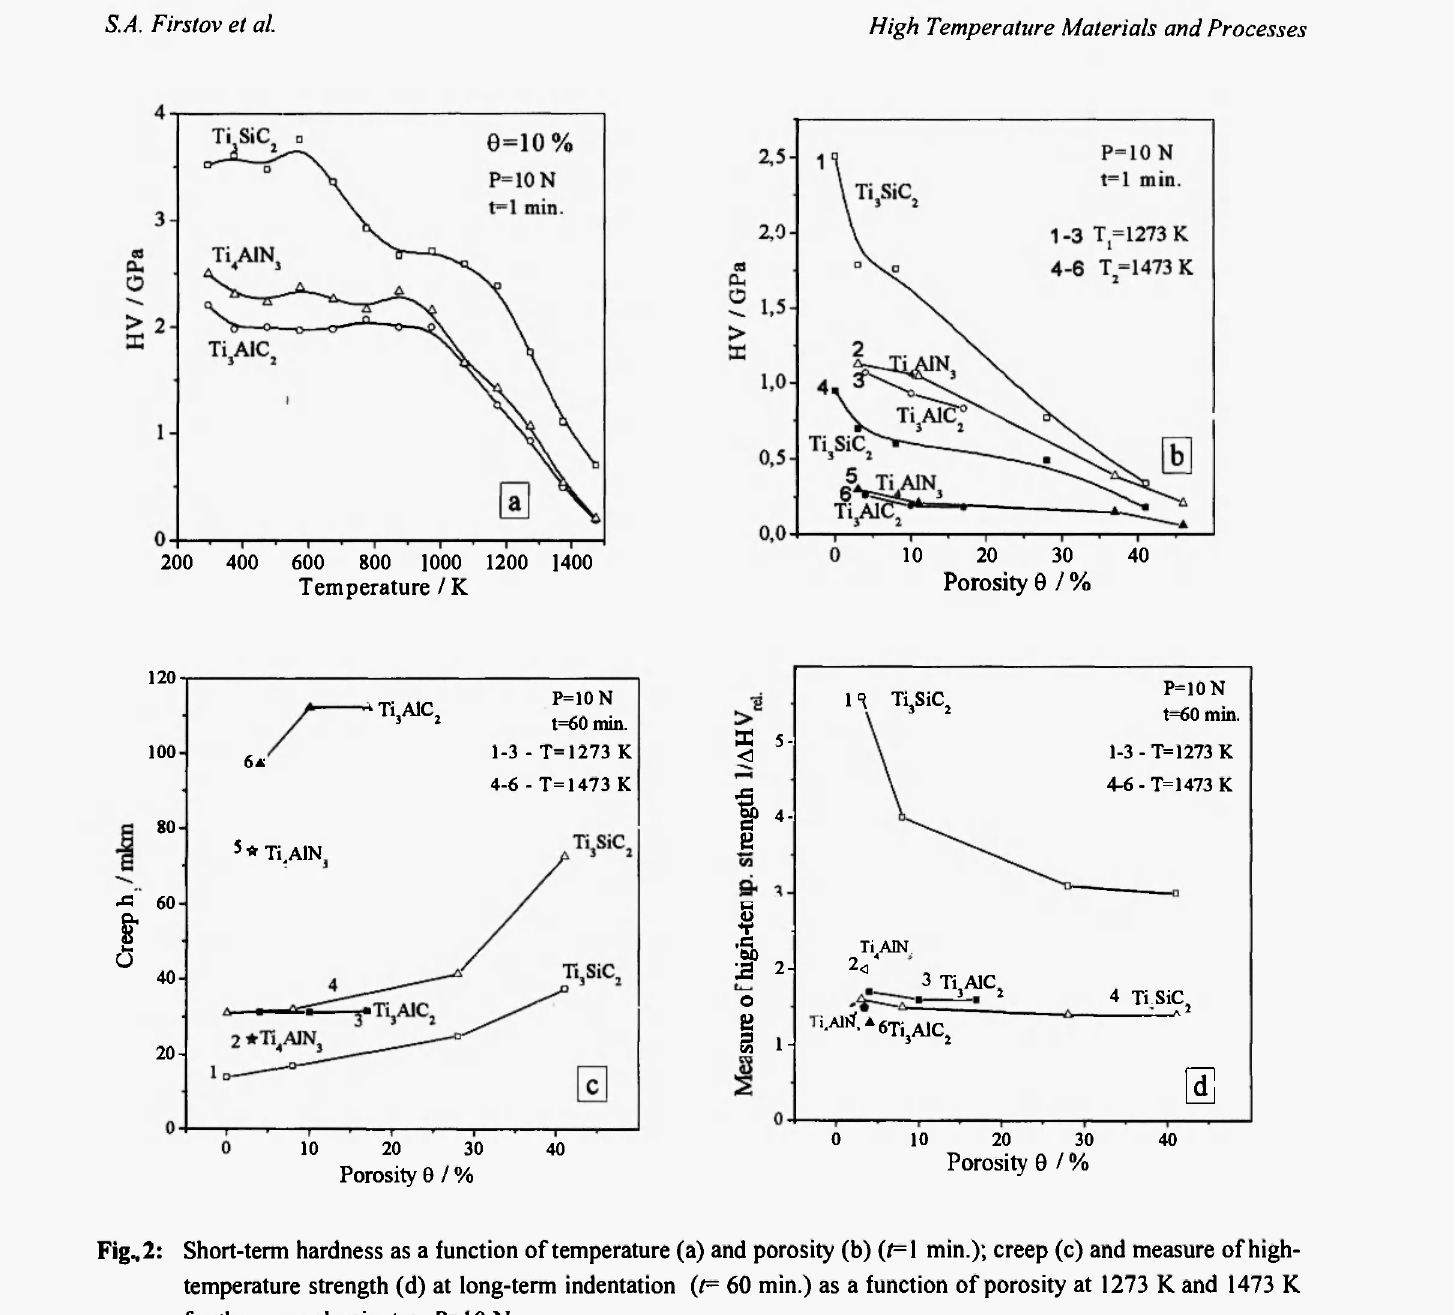
Fig., 2: Short-term hardness as a function of temperature (a) and porosity (b) (/=1 min.); creep (c) and measure of high- temperature strength (d) at long-term indentation (t= 60 min.) as a function of porosity at 1273 Κ and 1473 Κ for three-nanolaminates. P=10